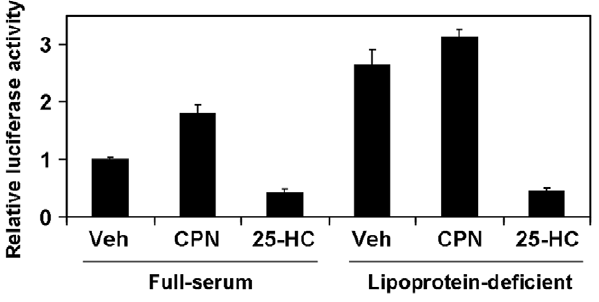
Figure 4. SRE-specific activity is saturated under lipoprotein- deficient conditions in PC-3 cells. PC-3 cells were transfected as described in Materials and Methods. Treatment included the statin compactin (CPN, 5 m M) or oxysterol 25-HC (1 m g/ml) for 24 h, in either full-serum (Medium A) or lipoprotein-deficient serum (Medium C). SRE- specific luciferase activity was determined as described in Materials and Methods, and normalized to the vehicle condition. Data are mean + SD, representative of 2 separate experiments. Each experiment was performed with triplicate wells per condition.